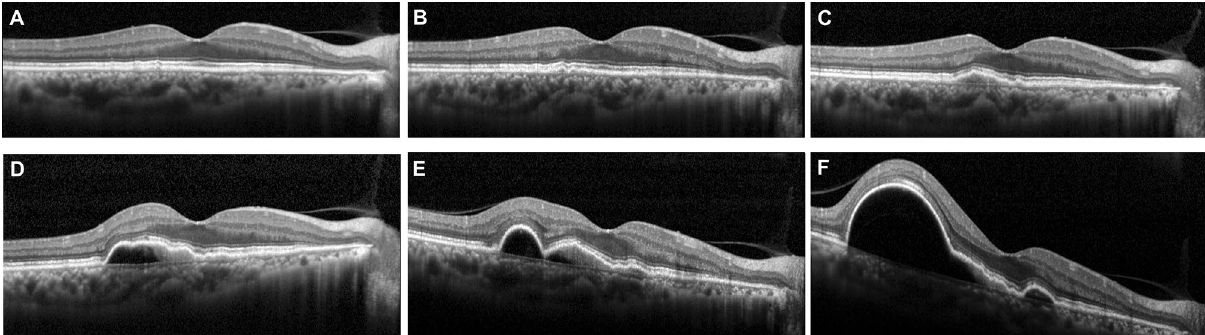
Figure 3. Even a small RPE irregularity or elevation may be an early precursor lesion of exudative macular neovascularization (MNV). This is a representative case of progression from small RPE irregularity or elevation to large polypoidal choroidal vasculopathy in 3 years and 6 months. Anti-vascular endothelial growth factor therapy had not been administrated until the occurrence of the subretinal fluid. All OCT series are horizontal section images of the same location across the center of the fovea. ( A ) Small RPE irregularity is noted with 620 µm length and temporal to the fovea. ( B ) One year after the first presentation, the small and shallow RPE elevation has been become more pronounced. The height and length of the lesion increased slightly. ( C ) At 1 year 9 months after the first presentation, double-layer sign with low to medium internal reflectivity